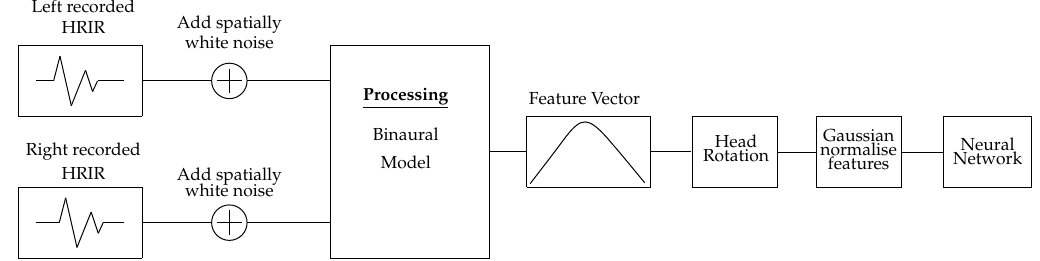
Figure 2. Signal processing chain used to generate the training data used to train the neural network.